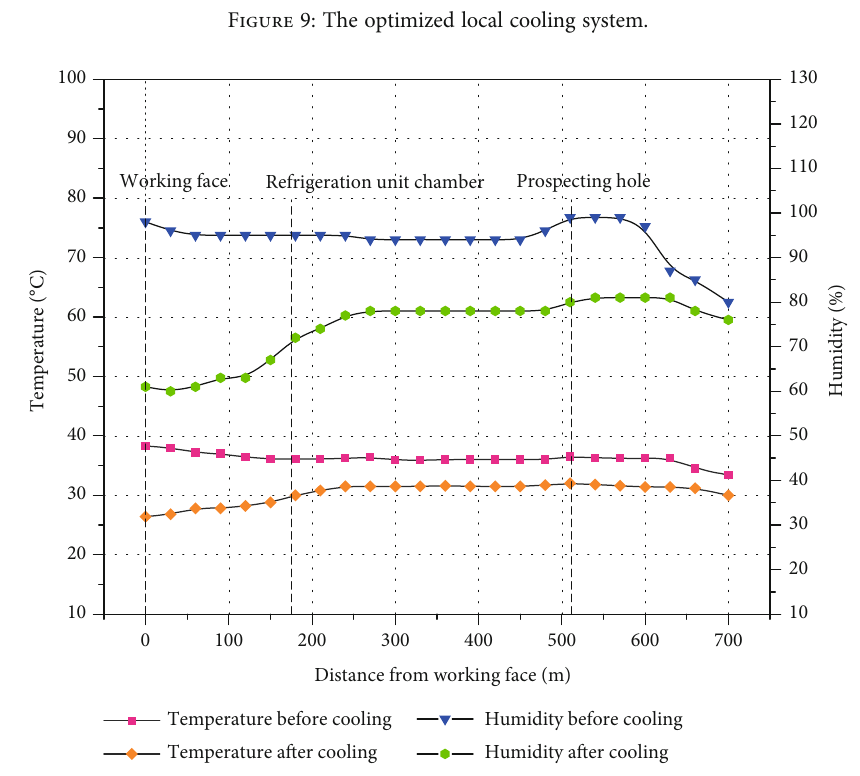
Figure 10: Temperature and humidity change